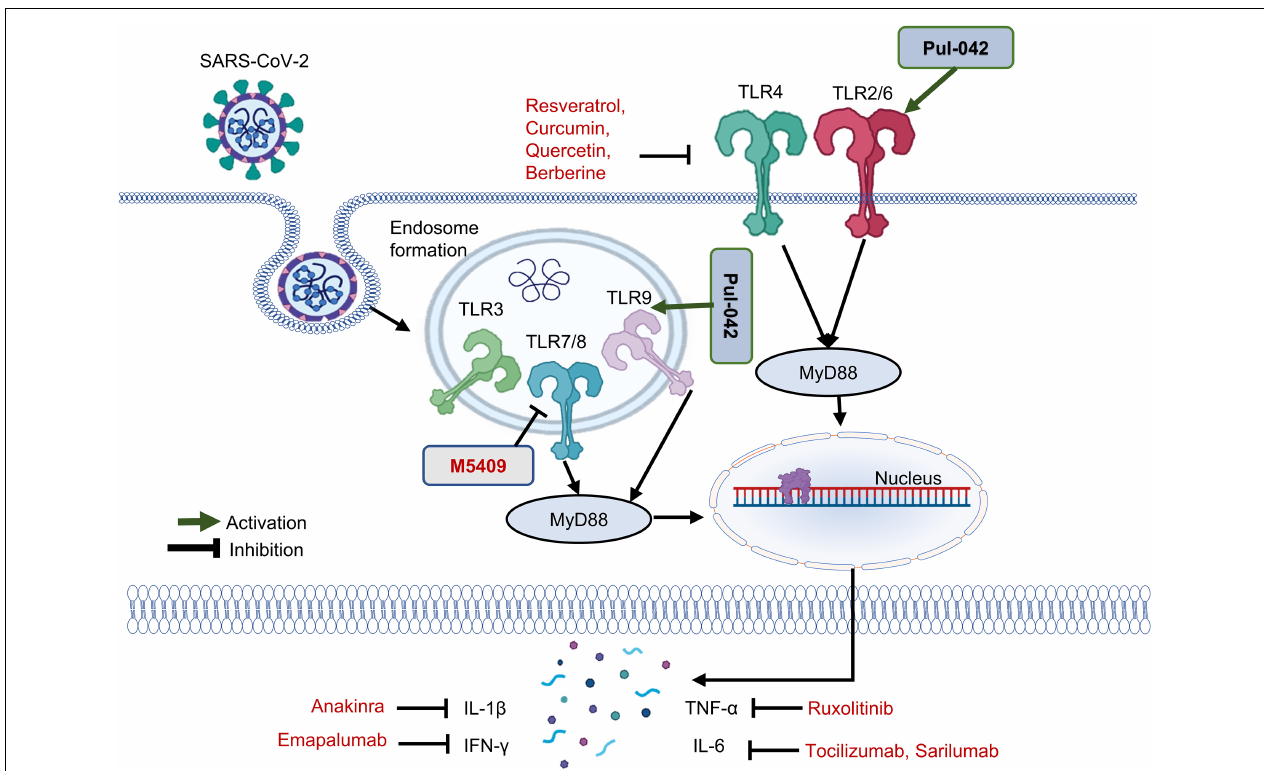
FIGURE 2 | Toll-like receptor (TLR) triggering SARS-CoV-2 infection. SARS-CoV-2, in addition to its main receptor ACE-2, can enter the cell through interaction with TLRs. Currently, TLR4 antagonists including resveratrol, curcumin, quercetin, and berberine are in clinical trials. Pul-042 is a TLR2/6/9 agonist, which stimulates T-helper cells mediated cytokine and interferon secretion. To control a cytokine storm, anakinra, emapalumab, and ruxolitinib are being tested, which are monoclonal antibodies against IL-1 β , IFN- γ , and TNF- α . Against IL-6, tocilizumab and sarilumab can be used. M5049, a TLR7/8 antagonist, is currently being tested in clinical trials against